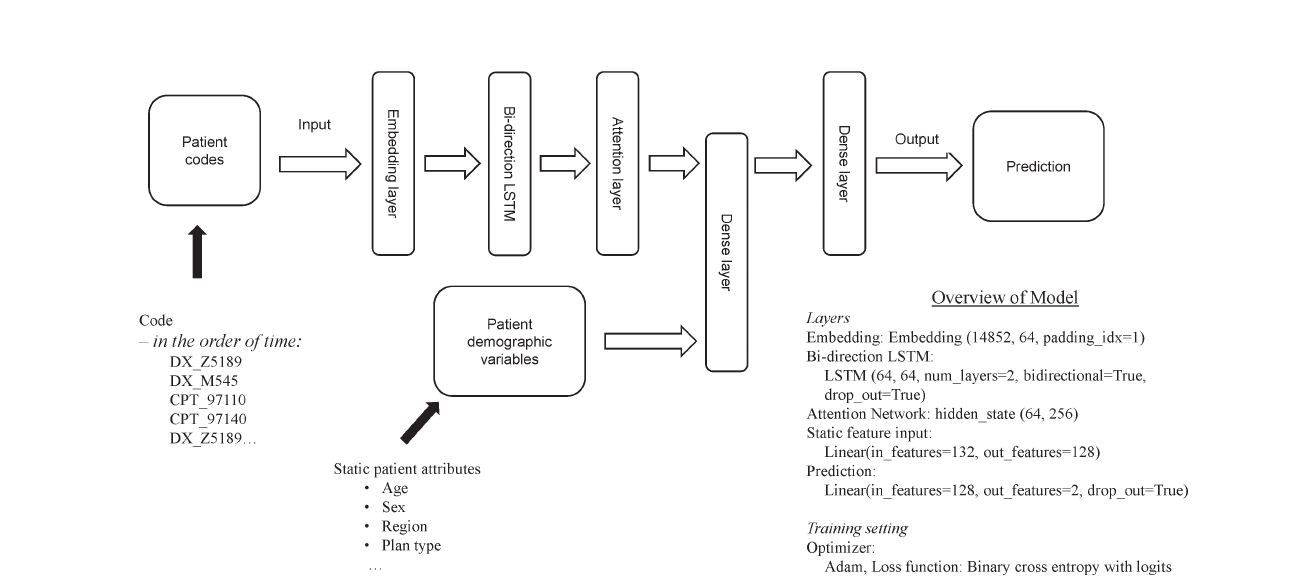
Figure 2. Deep Learning Model Design: Sequential Model